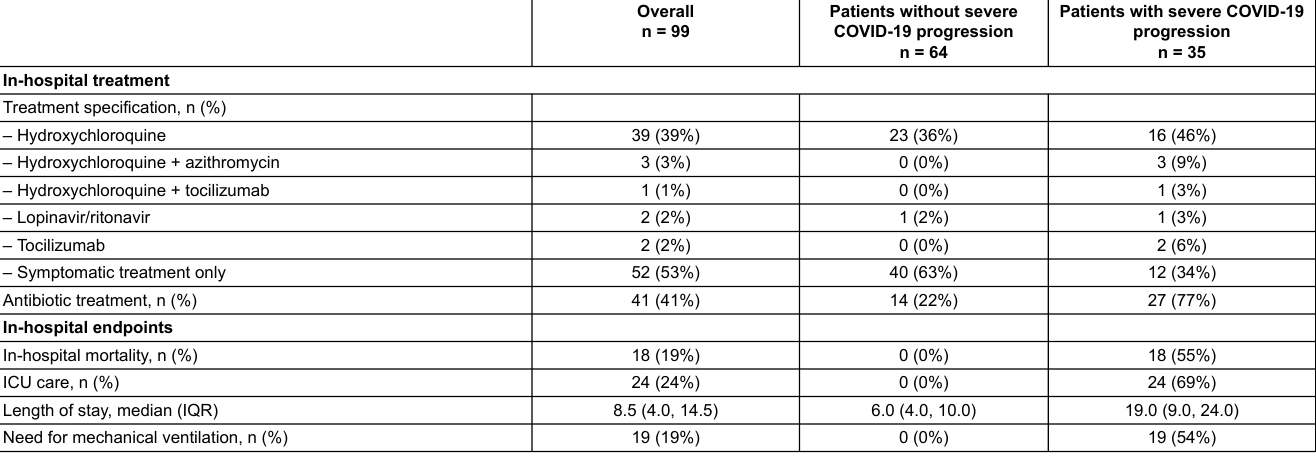
Table 2: In-hospital treatment and endpoints of patients hospitalised owing to COVID-19.